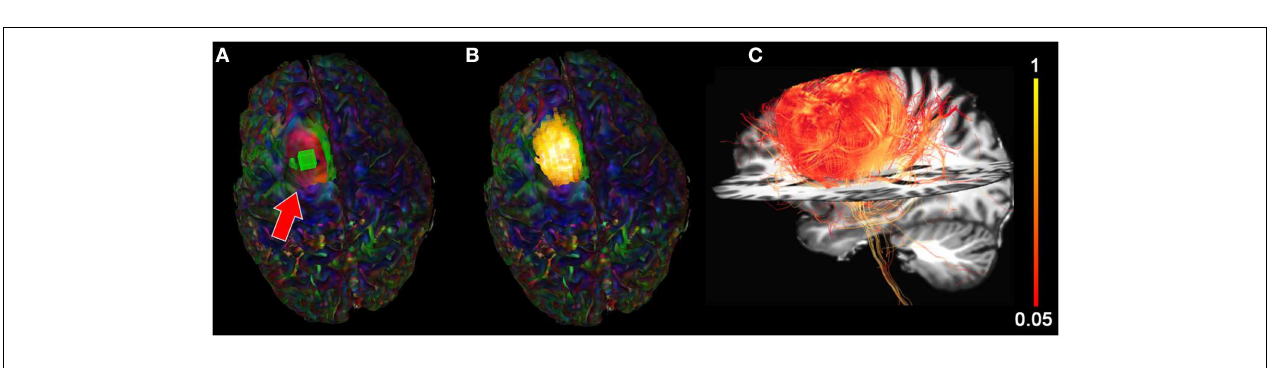
FIGURE 7 | Surgical application using resting-state driven tractography to uncover the functional and structural motor network of a 31 years old tumor patient with astocytoma of grade III. (A) Seed-ROI (blue box, red arrow) interactively positioned in the motor cortex.